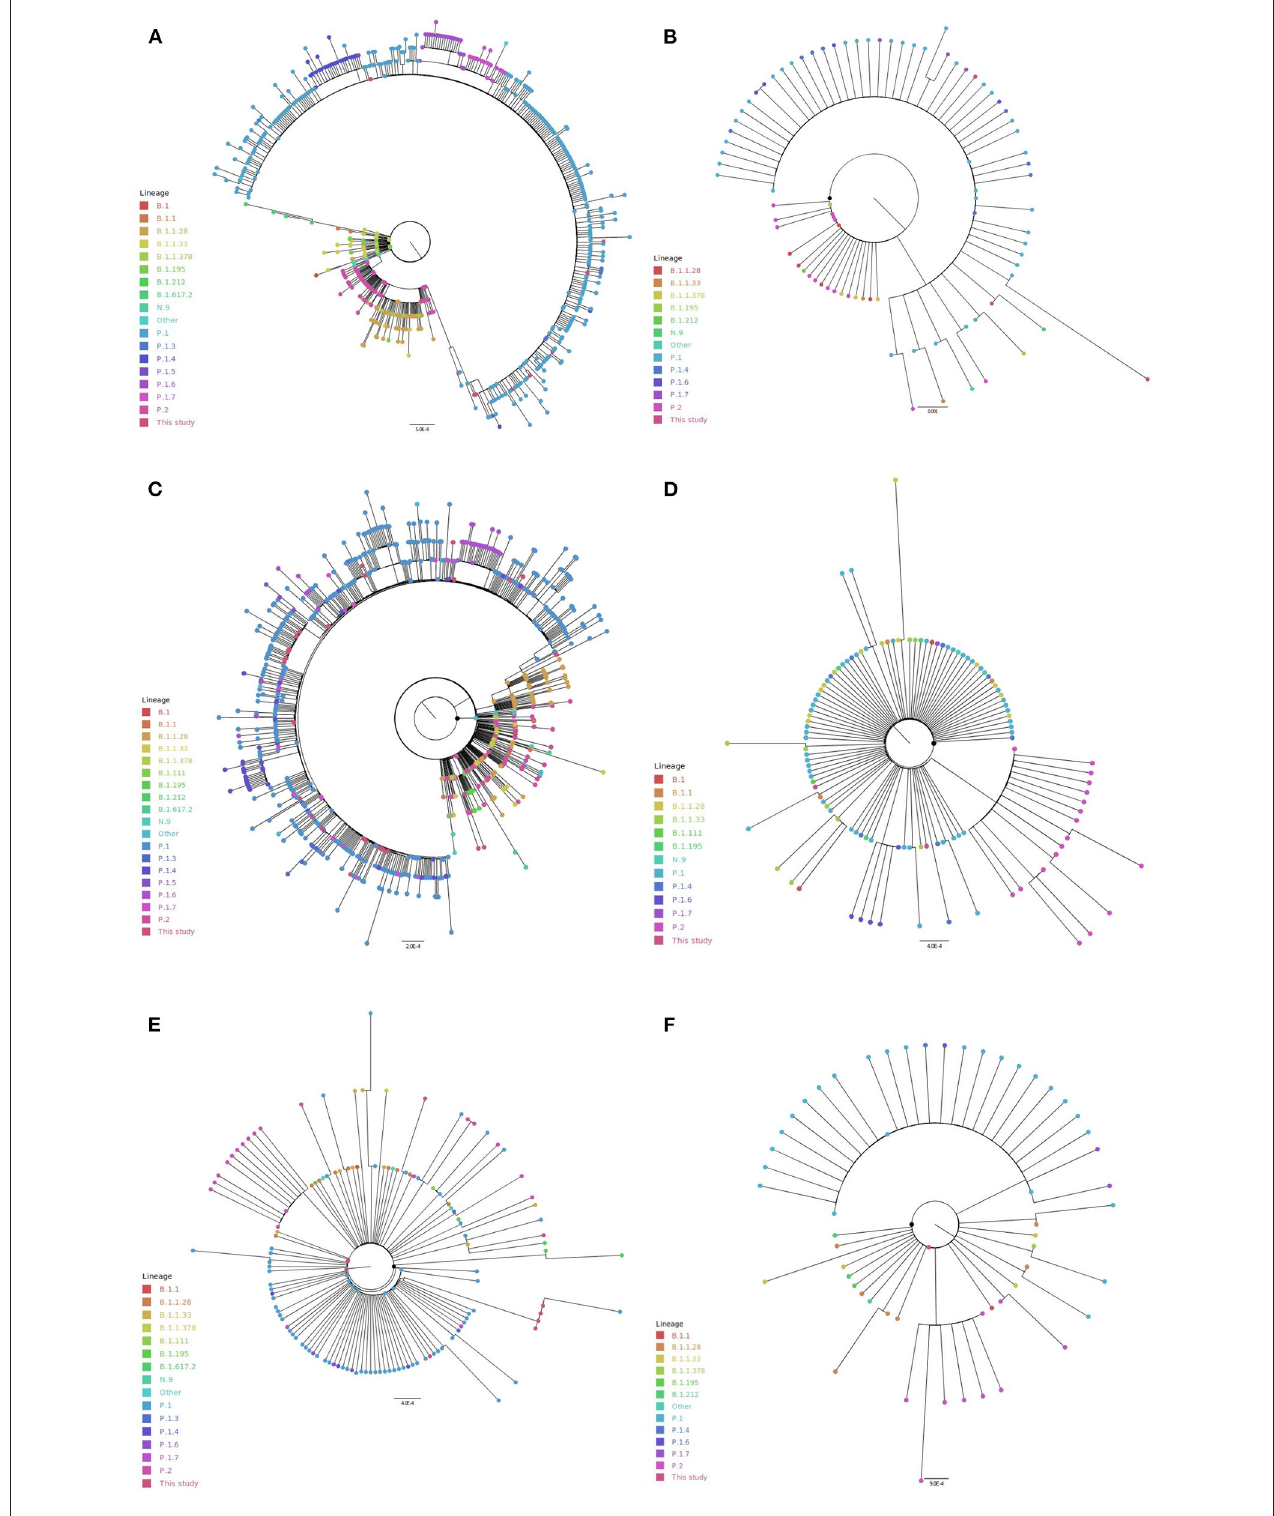
FIGURE 5 | Phylogenetic analyses of spike and non-structural proteins from ORF1a including northern Brazilian SARS-CoV-2 genomes. (A) spike, (B) NSP1, (C) NSP3, (D) NSP5, (E) NSP6, and (F) NSP9.